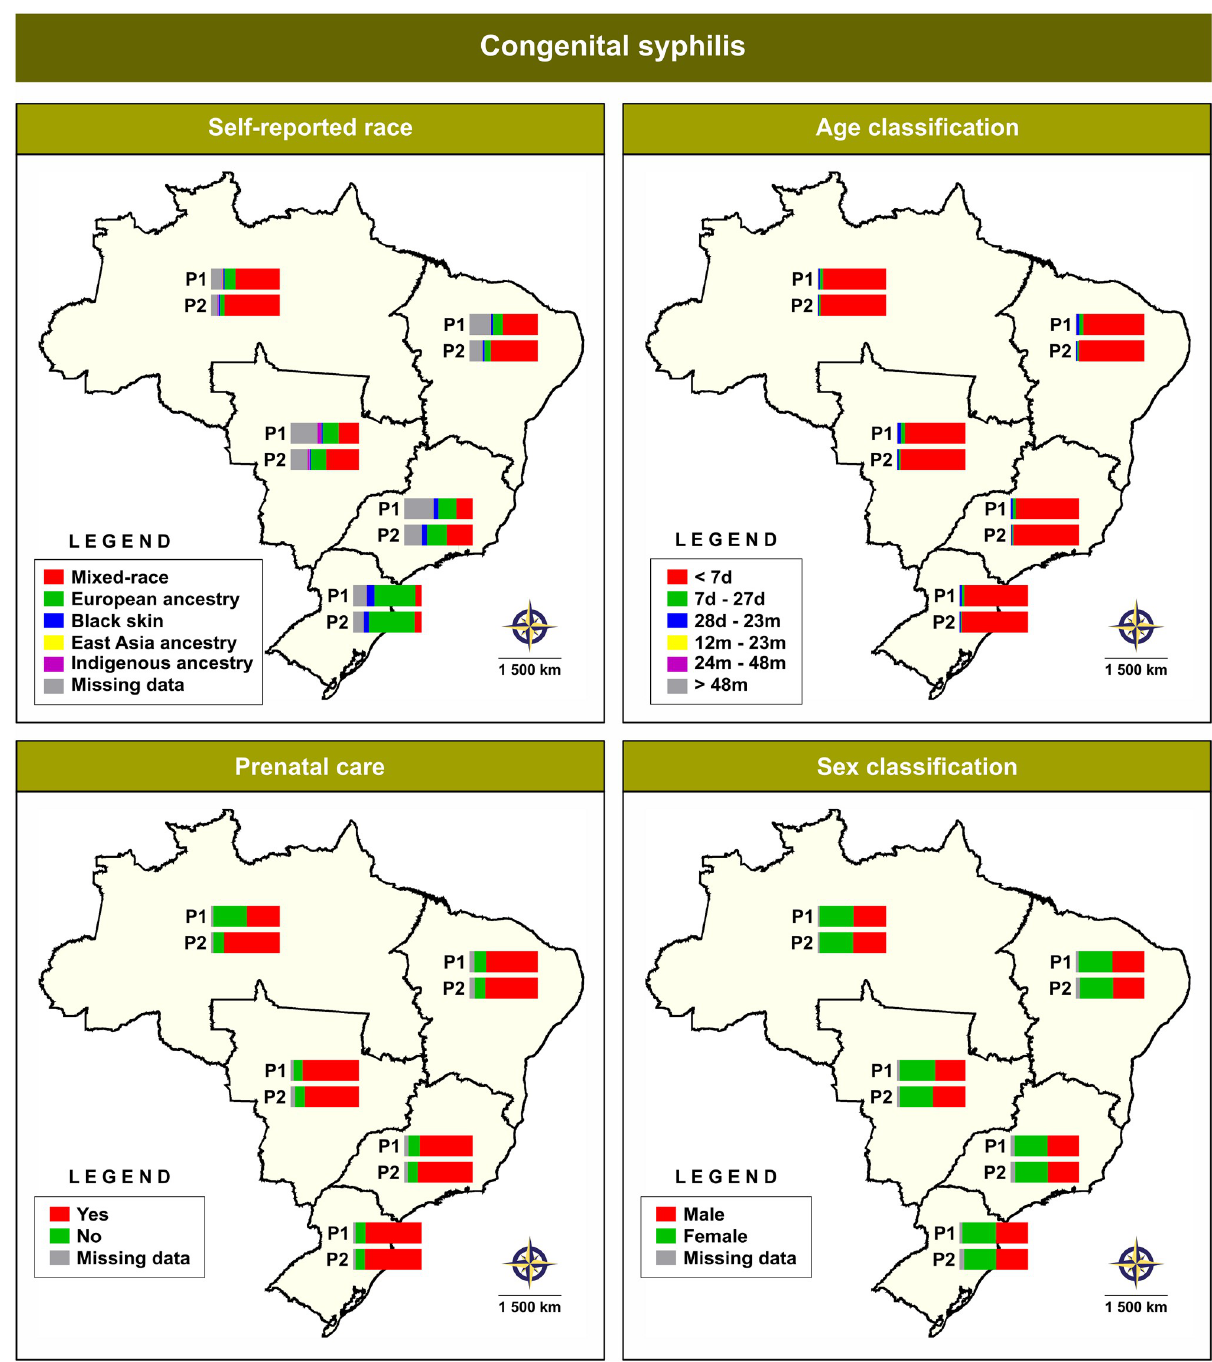
Fig 3. Analysis of changes in sociodemographic variables by region, stratified according to two periods of CS notifications. Digital maps in the public domain (publicly available) were obtained from IBGE cartographic database in shapefile format (.shp), which was subsequently reformatted and analyzed using QGIS version 3.10. Authors specify that this figure is licensed under CC BY 4.0.